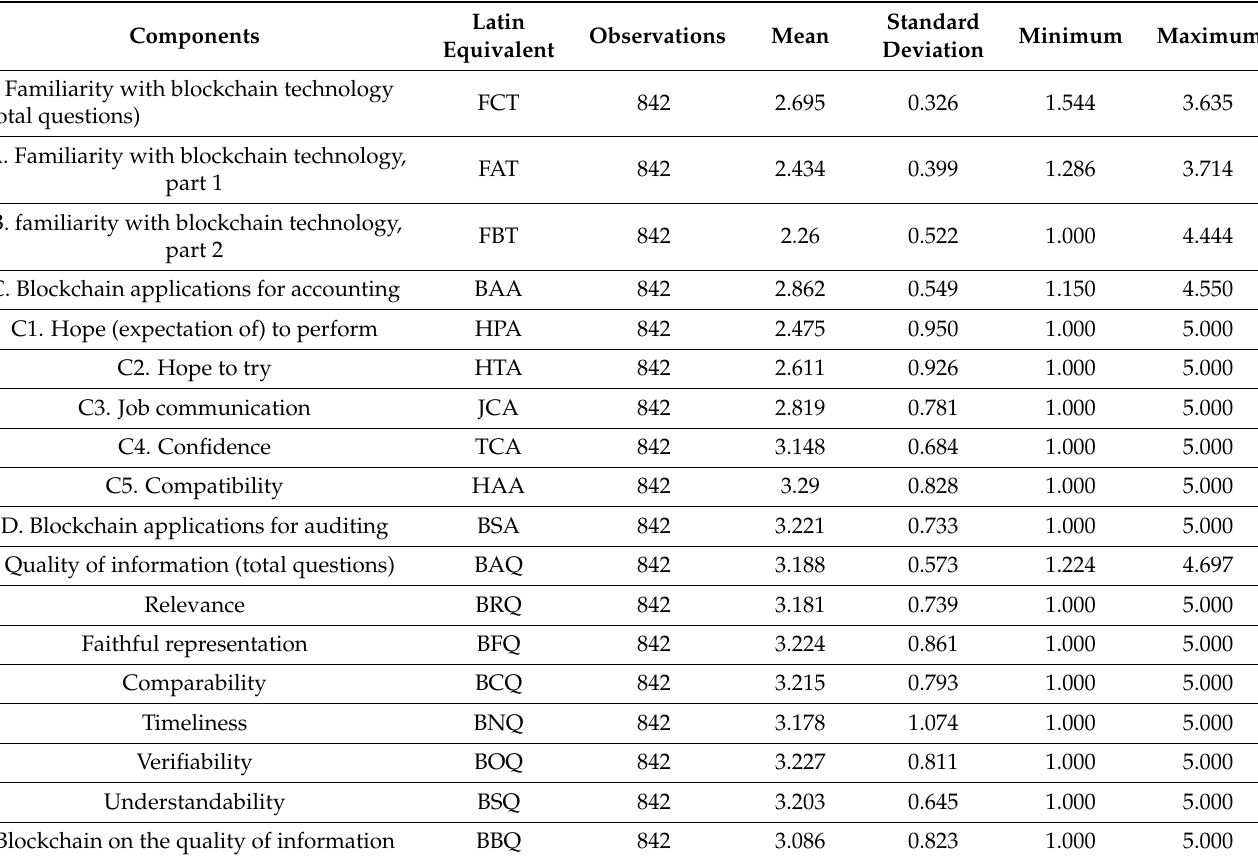
Table 5. The descriptive statistics of hidden variables for stock exchange company